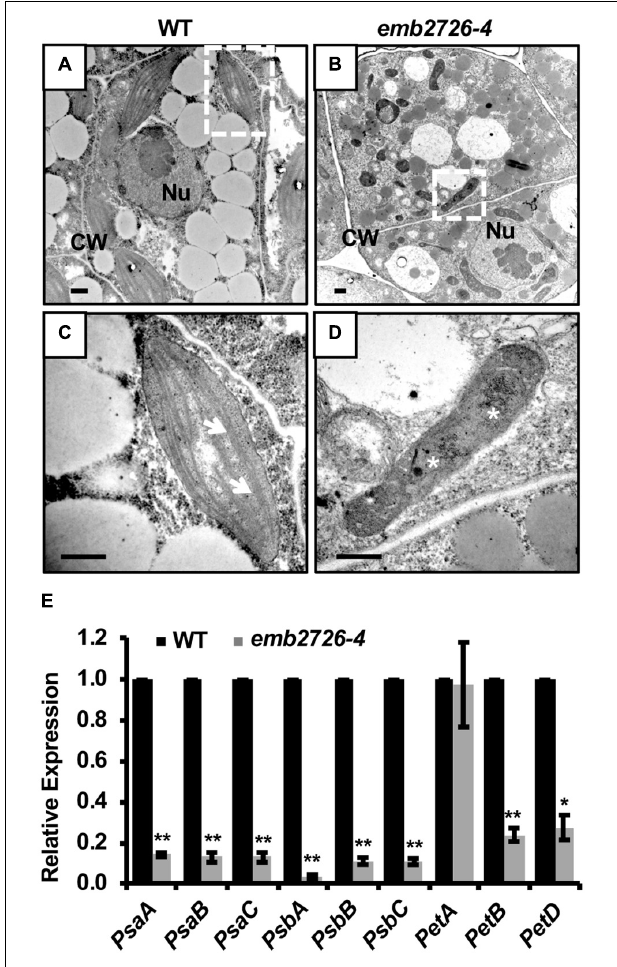
FIGURE 5 | Chloroplast development is disrupted in emb2726-4 embryo cells. (A,B) Cells in WT and emb2726-4 embryos at 5 DAP. Nu, nucleus; CW, cell wall. (C,D) Enlarged images of the plastids in white boxes in (A,B) , respectively. Arrows show the grana and asterisks show the possible phytoferritin aggregations. Scale bar = 0.5 µ m. (E) The relative transcription level of plastid-encoded photosynthesis-related genes in WT and mutant embryos from emb2726-4/ + siliques at 7 DAP. The asterisks indicate significant differences by Student’s t -test using three biological repeats. PP2AA3 was used as an internal control. * P < 0.01, ** P < 0.001.